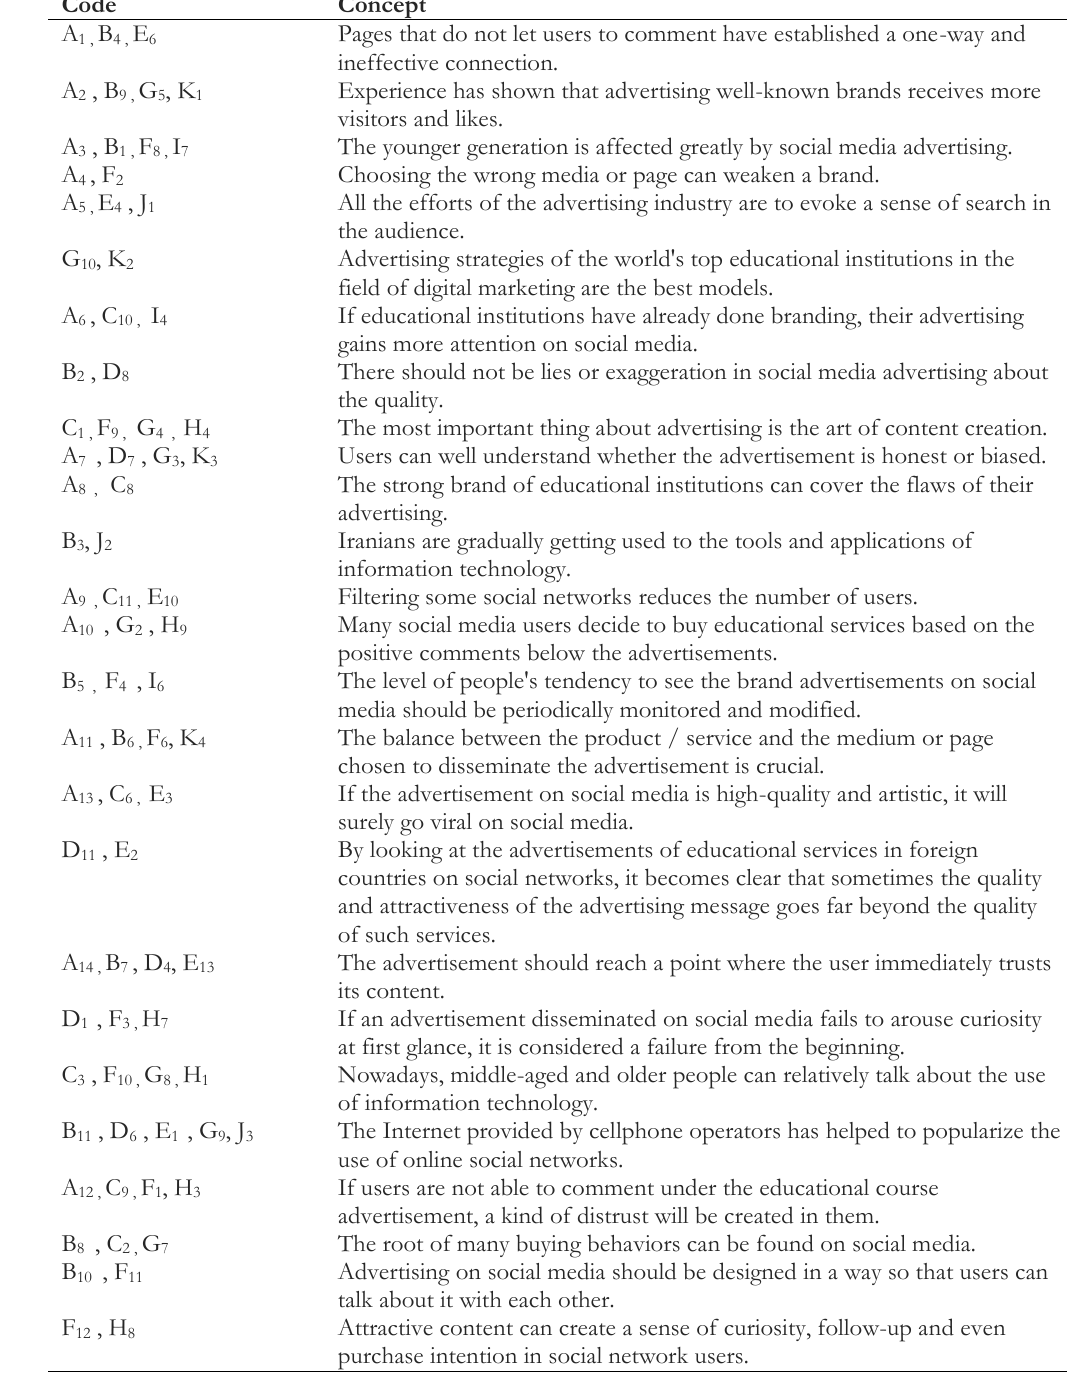
Table 1. Finalized concepts after analyzing the interviews and removing duplicate items in the open coding